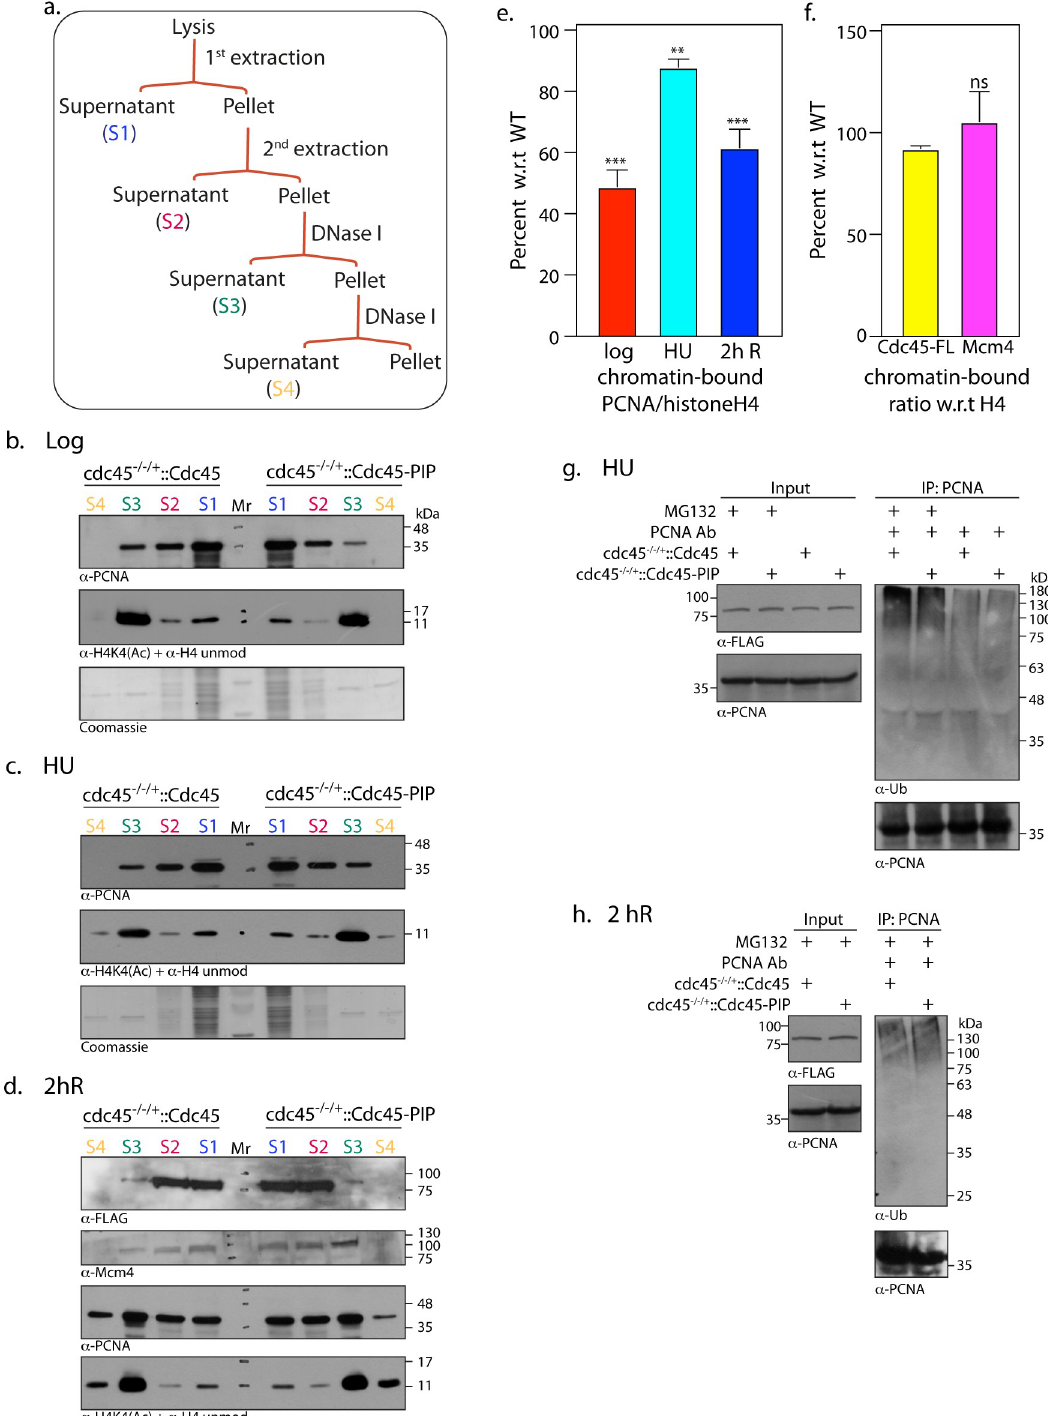
Fig 6. Cdc45 helps recruit/stabilize PCNA-polymerase complexes on chromatin during active DNA replication. a-e. Analysis of soluble and chromatin-bound protein fractions isolated from cdc45 -/-/+ ::Cdc45 and cdc45 -/-/+ ::Cdc45-PIP cells. Each experiment was carried out thrice. One data set for each is presented here. Reactions resolved on 12% SDS-PAGE were probed with various antibodies as indicated. S1, S2 –soluble fractions; S3, S4 –DNA-associated fractions. Mr- molecular weight marker a. Outline of fractionation scheme b. Isolation from 5 x10 7 logarithmically growing cells. c. Isolation from 5 x10 7 HU treated cells d. Isolation from 1–2 x10 9 synchronized cells 2 hours after release from block. e. ratio of chromatin-bound PCNA (S3+S4): histone H4 (S3+S4)